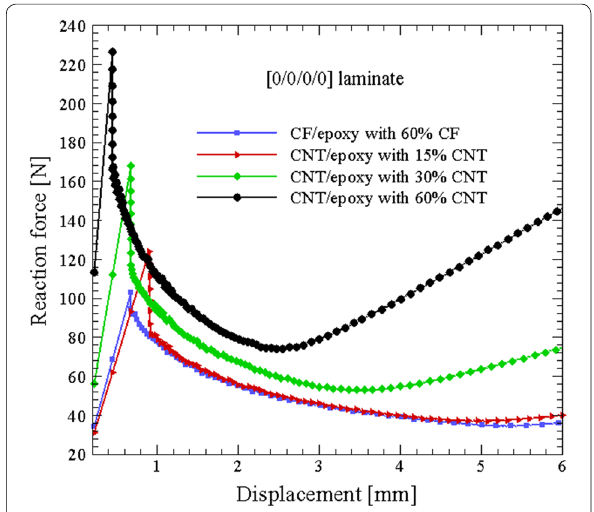
Fig. 10 Variation of reaction force with displacement at different fibre volume fractions for [0/0/0/0] stacking sequence of laminate